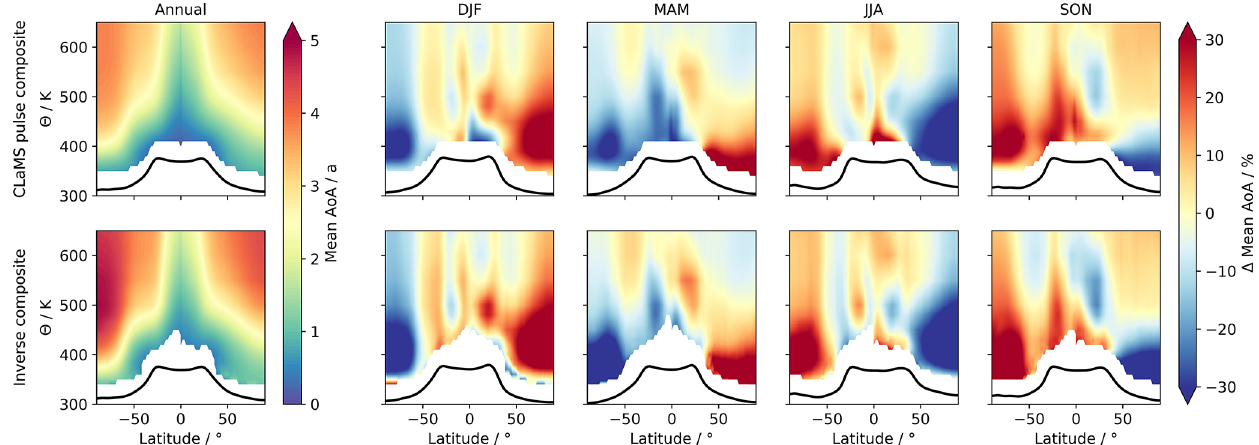
Figure 5. Global cross sections of mean age of air derived from the CLaMS pulse composite age spectra (top row) and from the inverse composite spectra (bottom row). The first column shows absolute values as the annual mean, and the right four columns show seasonal percentage differences relative to the annual mean. In all panels, the black line indicates the tropopause. The composite age spectra are calculated for this specific comparison using only annual mean origin fractions of the CLaMS model to focus explicitly on seasonality in mean AoA. Note that in the bottom row the larger areas of undefined values at the tropical tropopause are caused by the inversion algorithm not finding a valid solution for the transport parameter in that region. The first 30K above the tropopause is omitted in all